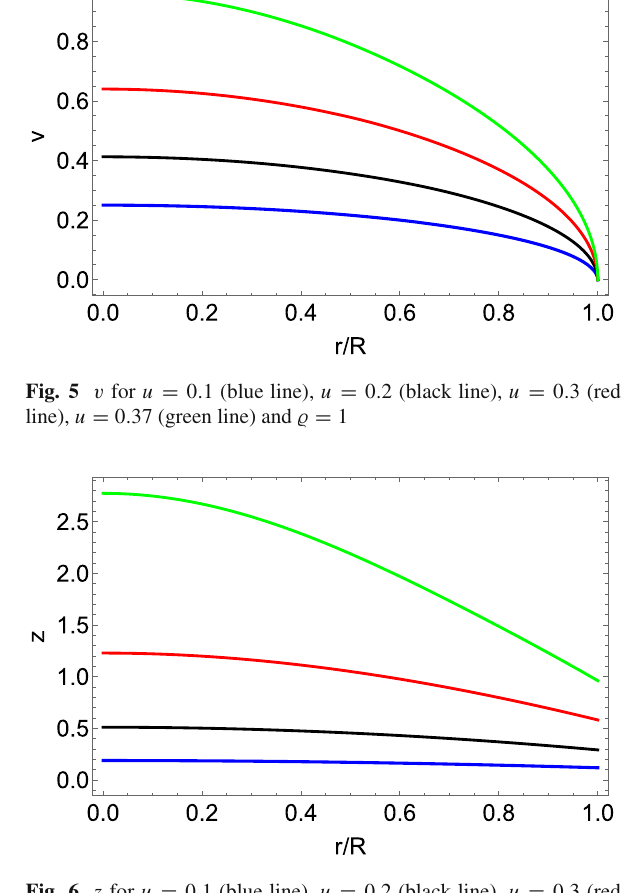
Fig. 6 z for u = 0 . 1 (blue line), u = 0 . 2 (black line), u = 0 . 3 (red line), u = 0 . 37 (green line) and (cid:13) = 1